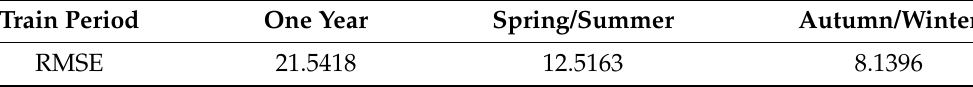
Figure 12. Comparison between target and forecast values for two weeks with the given training data. Table 2. Summary of the Root Mean Squared Error